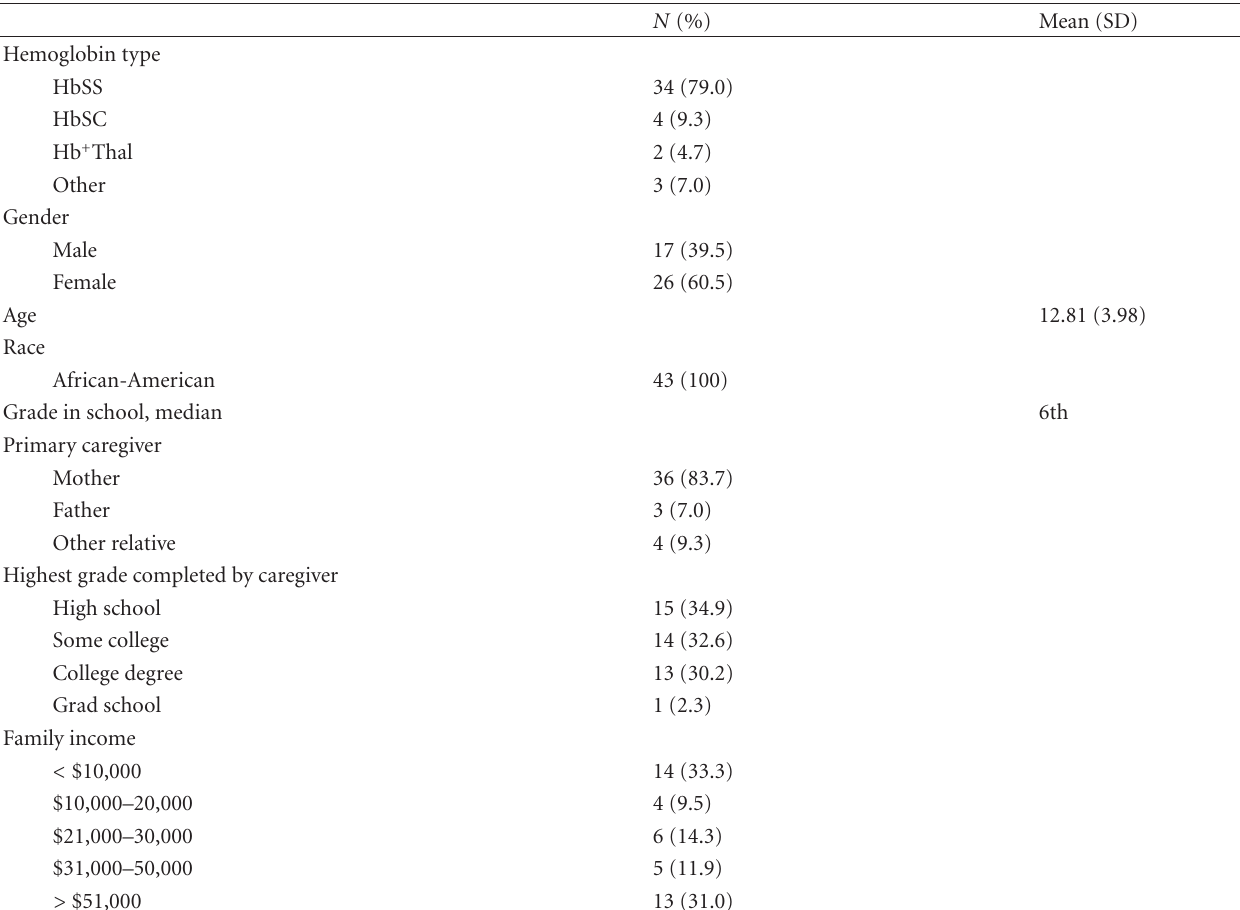
Table 1: Patient